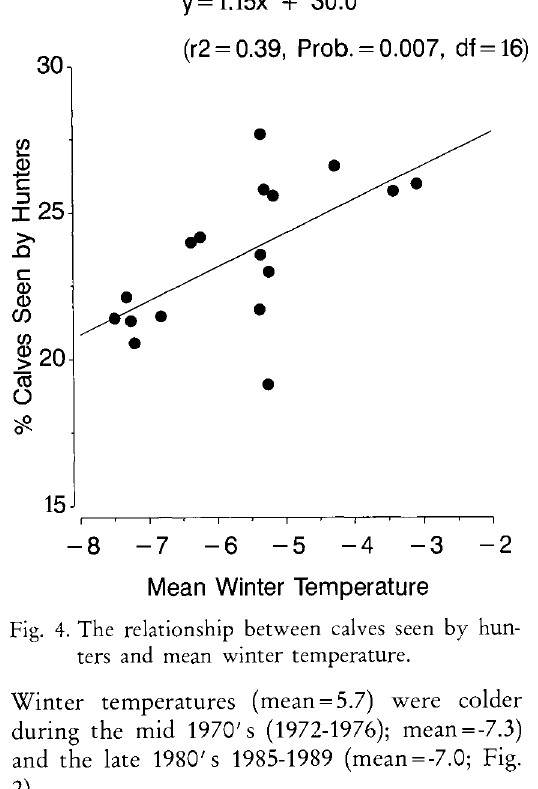
Fig. 4. The relationship between calves seen by hun ters and mean winter temperature.